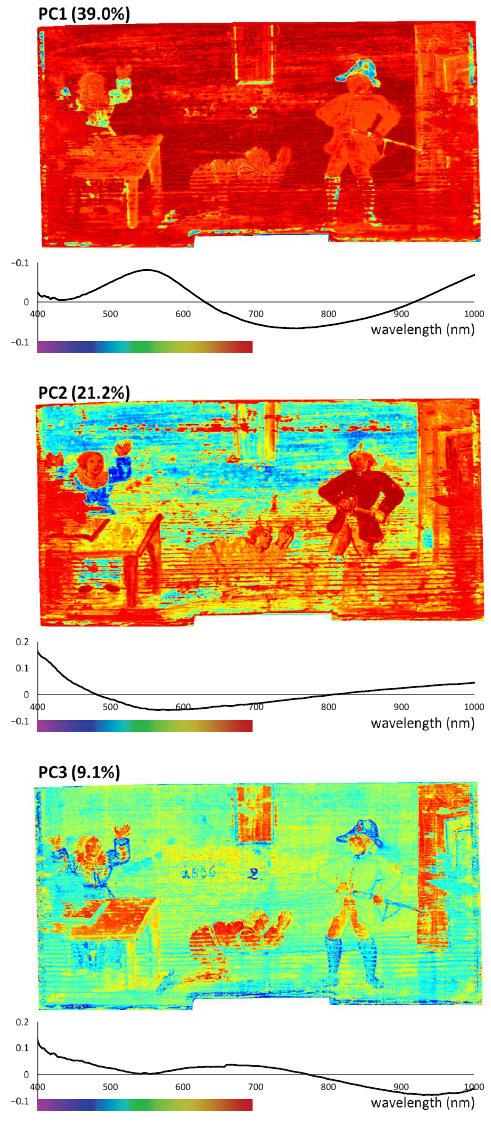
Figure 2. Results of principal component analysis (PCA) for images taken in the VIS–NIR spectral range. Note: The percentages in parentheses explain the variances of all the individual principal components.